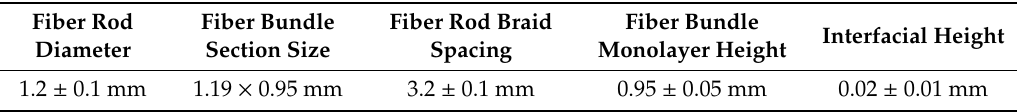
Table 2. Axially braided C / C composite material braided structure parameters (The data obtained from the observation of 100 samples).